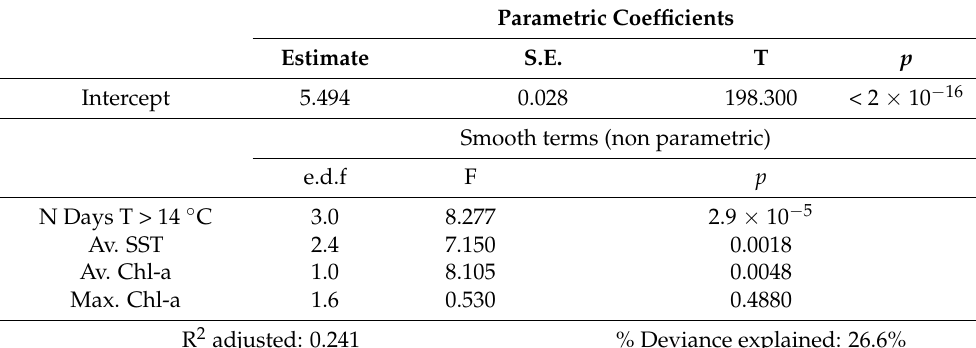
Table 6. Structure of the General Additive Model describing the best subset of environmental variables explaining relative fecundity (RF) along the Portuguese coastline from 2014 and 2017, grouped. Averages of Chlorophyll-a (Av. Chl-a, mg/m 3 ) and Sea Surface Temperature (Av. SST, ◦ C) at last month before samples. Number of days with Sea Surface Temperature higher than 14 ◦ C at last 4 months (N Days SST > 14 ◦ C). Average Chl-a concentration during 10 days around the peak of the spring transition (Max. Chl-a). S.E.: standard error; e.d.f.: estimated degrees of freedom. Parametric Coefficients